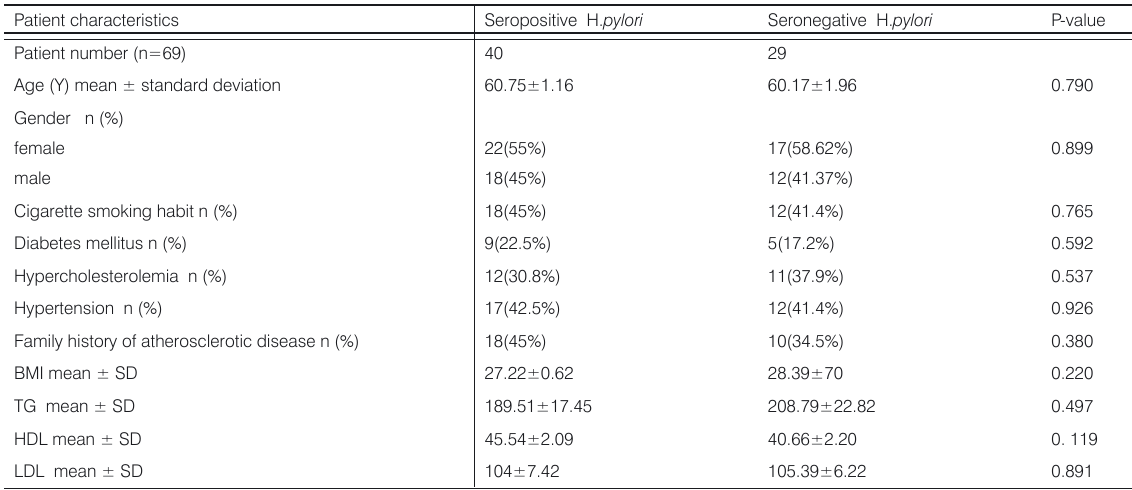
Table 5. Prevalence of CAD risk factors according to seropositive and seronegative H. pylori infection in the case group *.